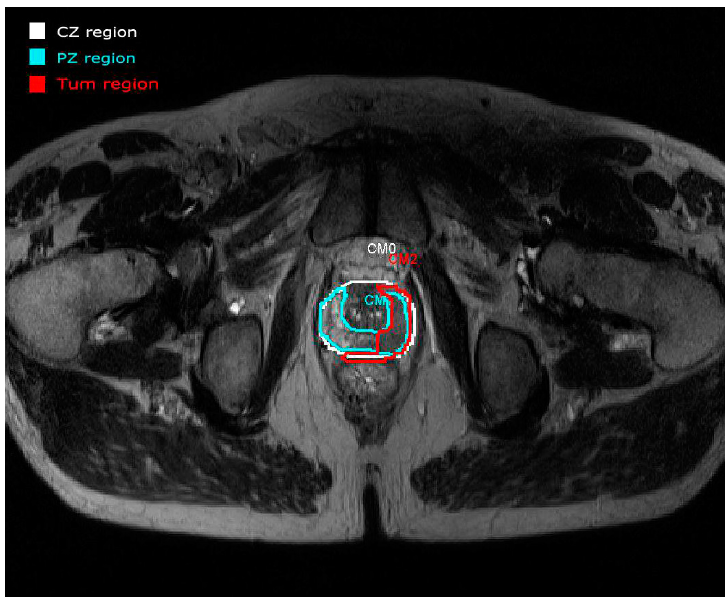
Figure 2. An example of the anatomy (T2WI) panel visualization of the tool developed in [11] with the ROIs annotated by